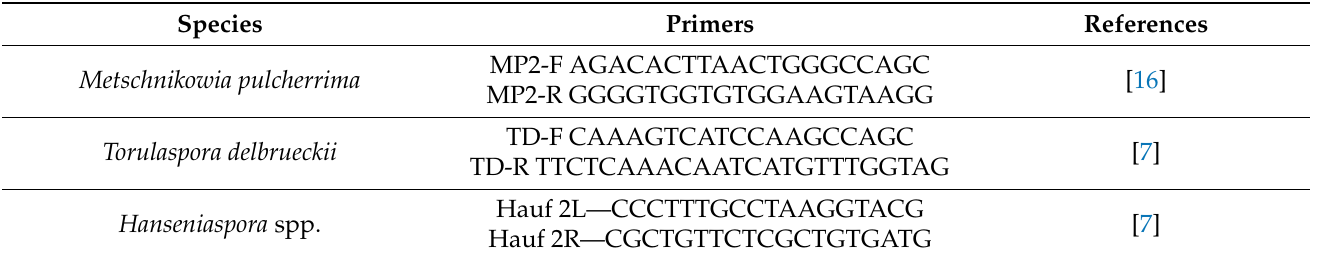
Table A2. Primers used to quantify population levels of microorganisms.